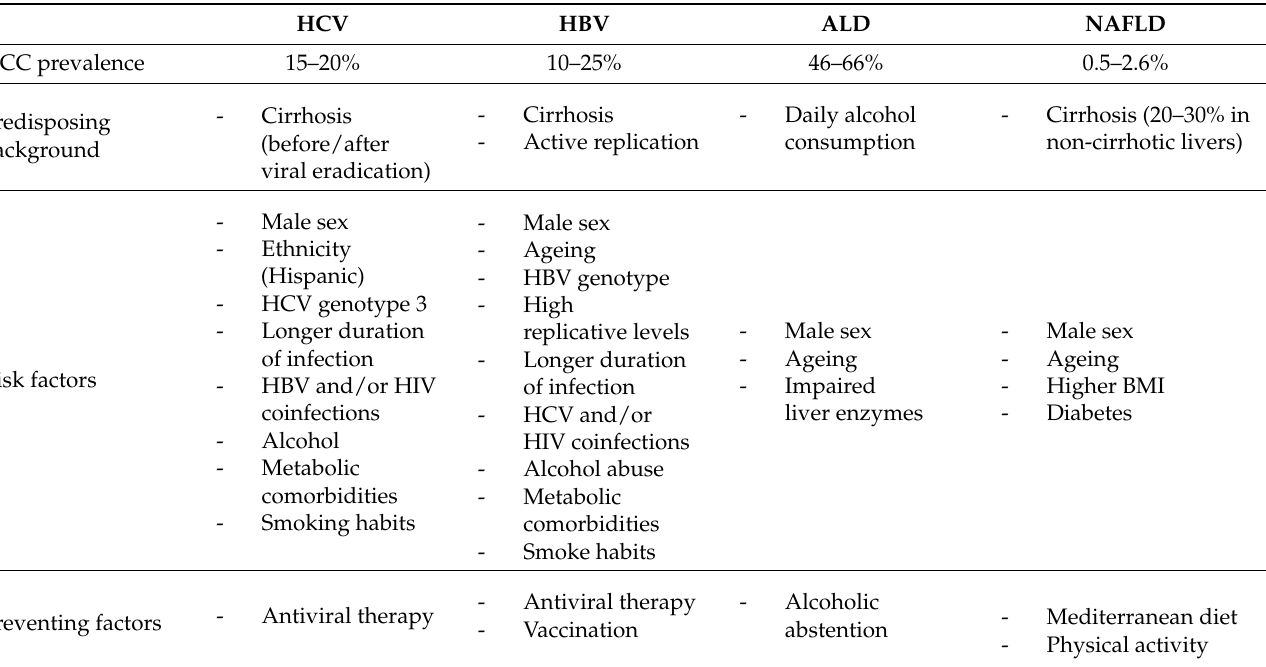
Table 1. Differences in HCC prevalence according to predisposing background, risk factors, and preventing strategies across the diverse